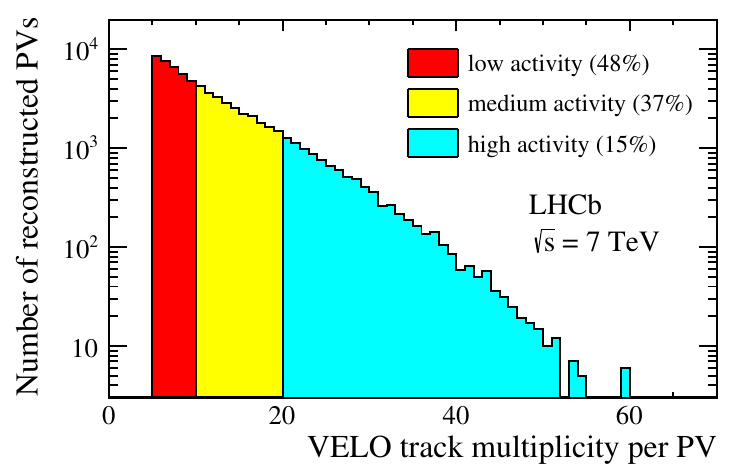
Figure 1 . Multiplicity of reconstructed VELO tracks assigned to a PV for the 2011 no-bias sample. Di(cid:11)erent colours indicate three activity classes de(cid:12)ned as fractions of the full distribution. The minimum value of the track multiplicity to accept reconstructed PV is